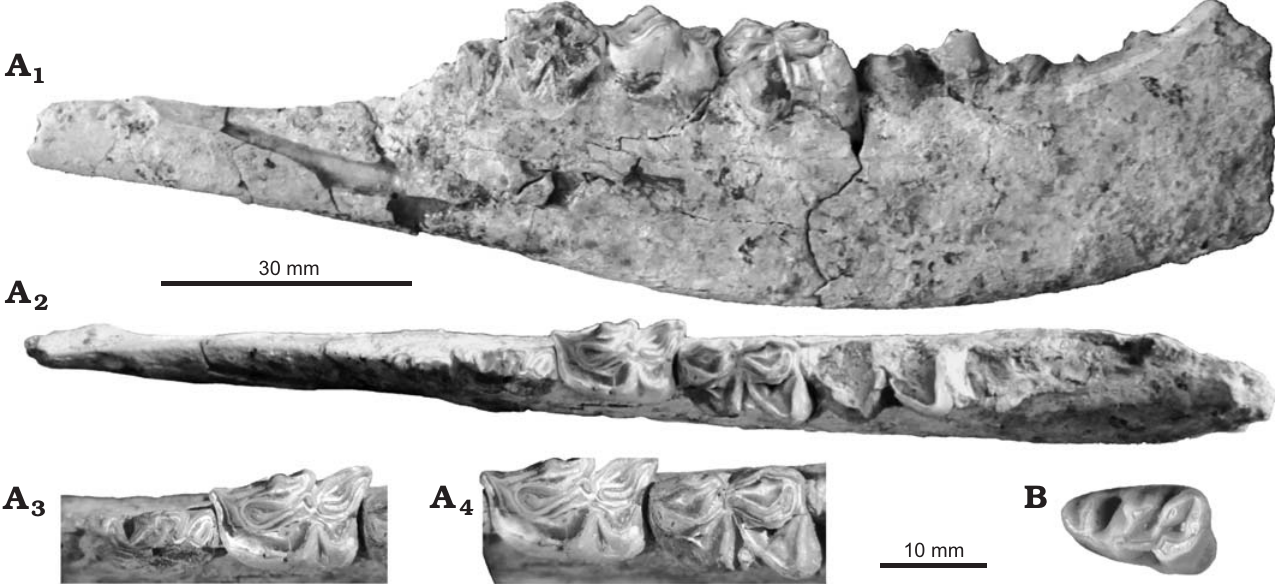
Fig. 3. Mandible and teeth of the cervid mammal Capreolus constantini Vislobokova, Dmitrieva, and Kalmykov, 1995 from the Pliocene of Hidalgo, Mexico. A . UAHMP 481, left mandible fragment in lateral (A view (A ). B . UAHMP 432, p3 in occlusal 4